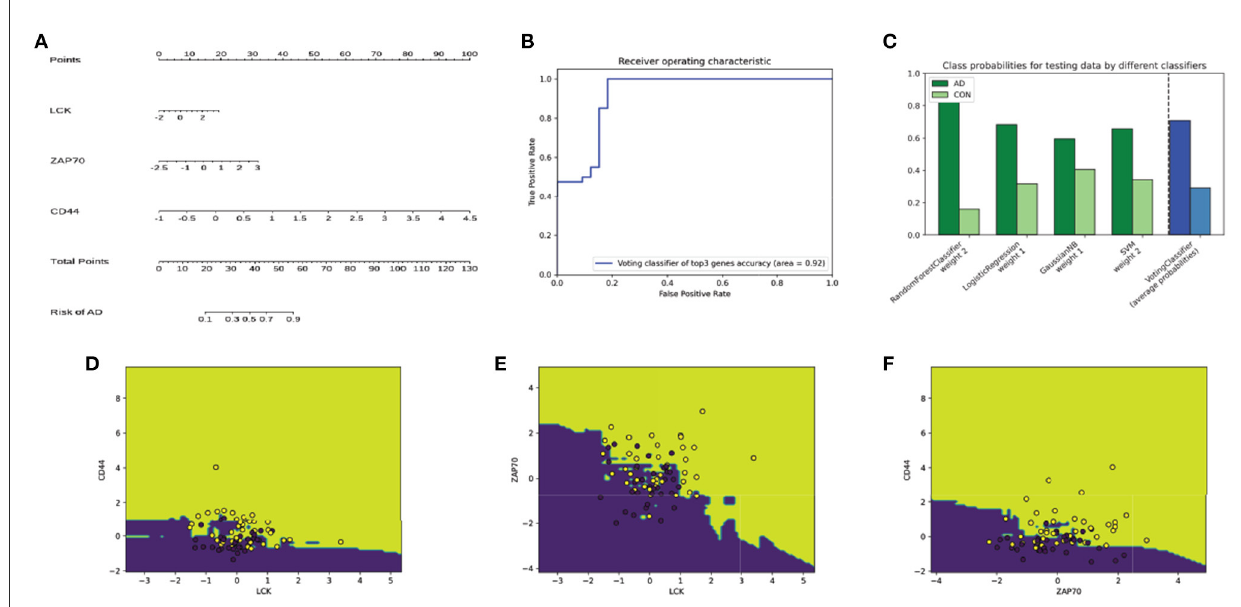
FIGURE5 Visualization of ensemble classifier model. (A) The nomogram can be used to predict the risk of AD according to the expression of top hub genes. (B) The ROC of the model; the area under the ROC is 0.92 representing the accuracy of the model. (C) The green bar represents predicted probabilities for each model, and the blue bar represents the ensemble model. Its distribution is generally consistent in every single model. (D–F) The decision boundaries of the ensemble model with CD44 and LCK (D) , ZAP70 and LCK (E) , CD44 and ZAP70 (F) as input. Dark yellow dots are the samples predicted as AD, whereas dark blue dots are the samples predicted as non-AD. The dark yellow and dark blues areas represent AD and non-AD predicted space, respectively.